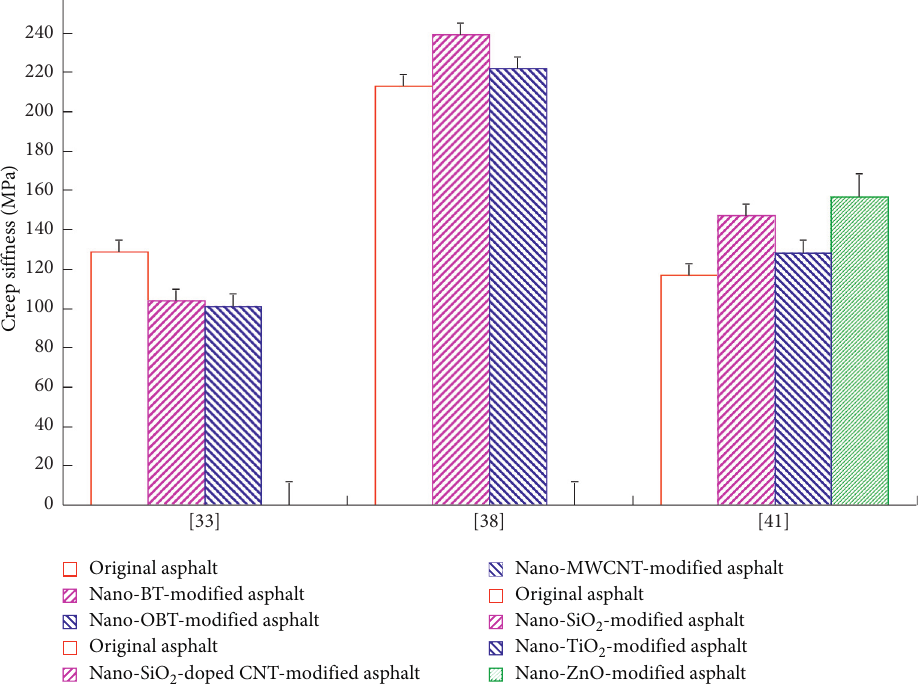
Figure 8: Creep stiffness of nanomodified asphalt at − 12 °